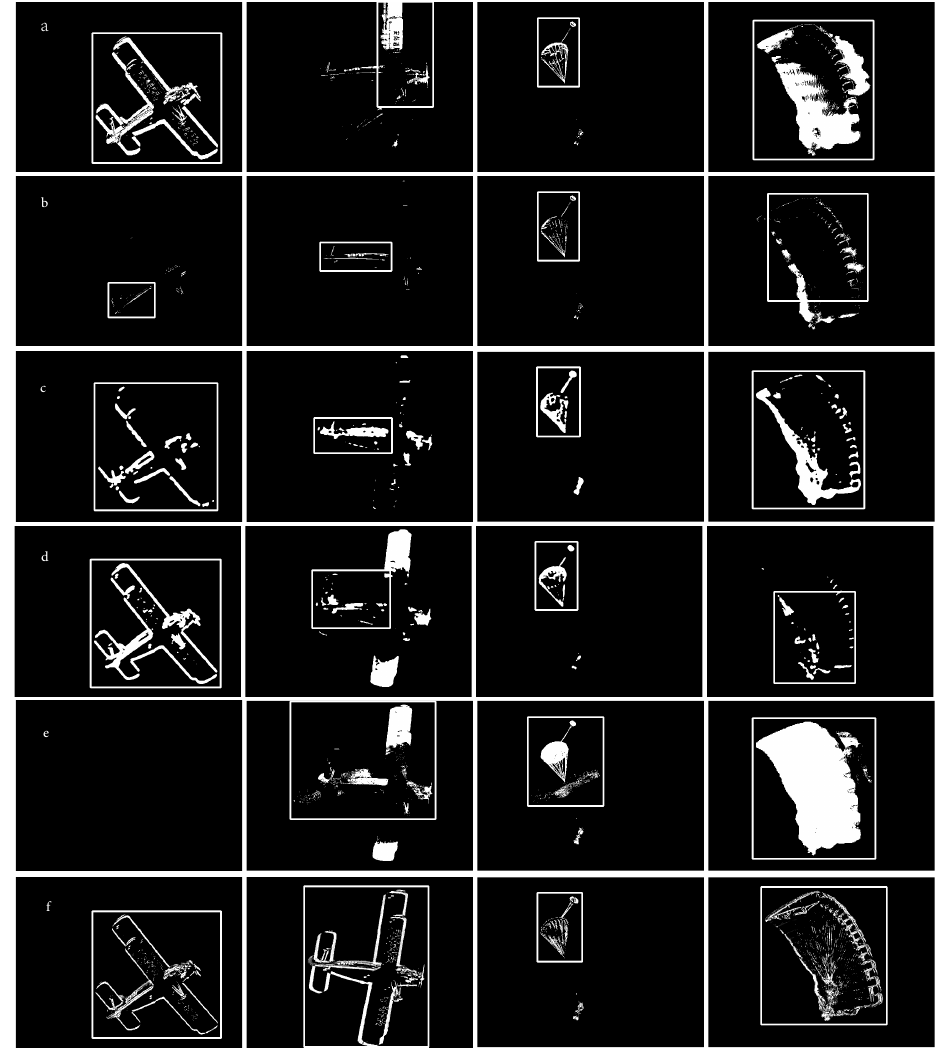
Figure 17. From top to bottom are ( a – f ), and from left to right are the foreground with the bounding box at different moments in